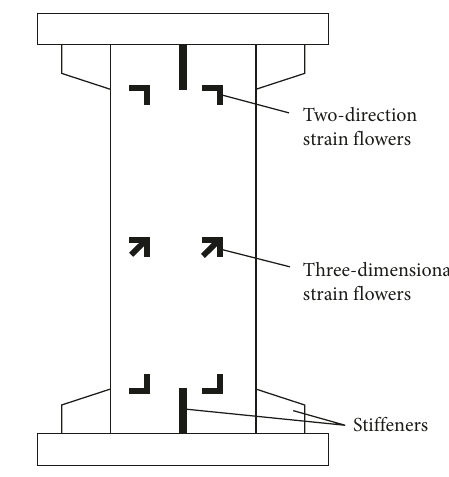
Figure 3: Measurement of steel tube